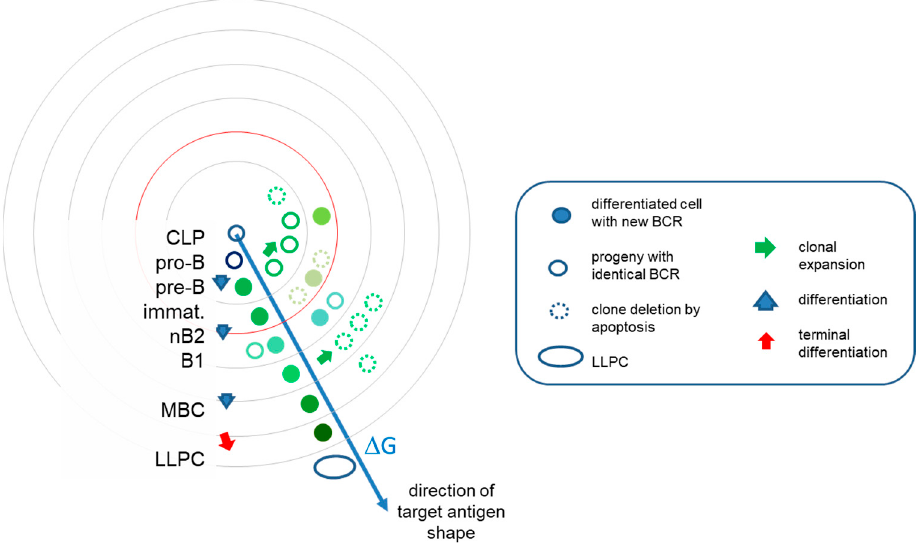
Figure 3. B-cell development in interaction space. The evolution of the system of antibodies can be interpreted as clones filling the interaction space at various levels of resolution. Along this pathway, cells continually increase their BCR affinity towards the target. Beyond the mean energy of the system, represented by red circle, TD responses allow further directed differentiation via somatic hypermutations in germinal centers. Clonal expansions are however followed by retraction, effector cells eliminated by apoptosis and only memory B cells and plasma cells surviving. Different colors stand for structural differences and relationships. LLPC, long-lived plasma cell; MBC, memory B cell; immat, immature B cell.